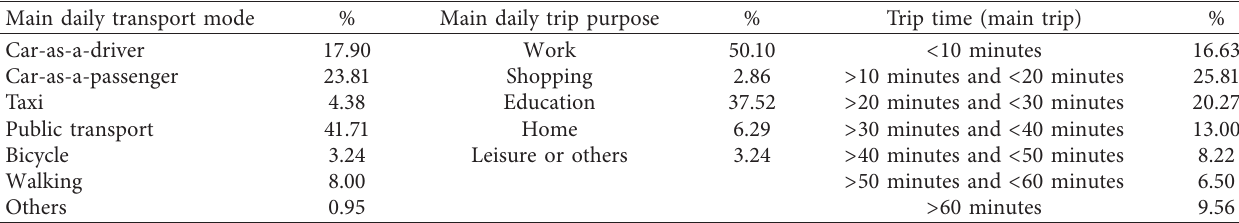
Table 2: The participants’ trip purposes, transport modes, and trip time statistics. Main daily transport mode